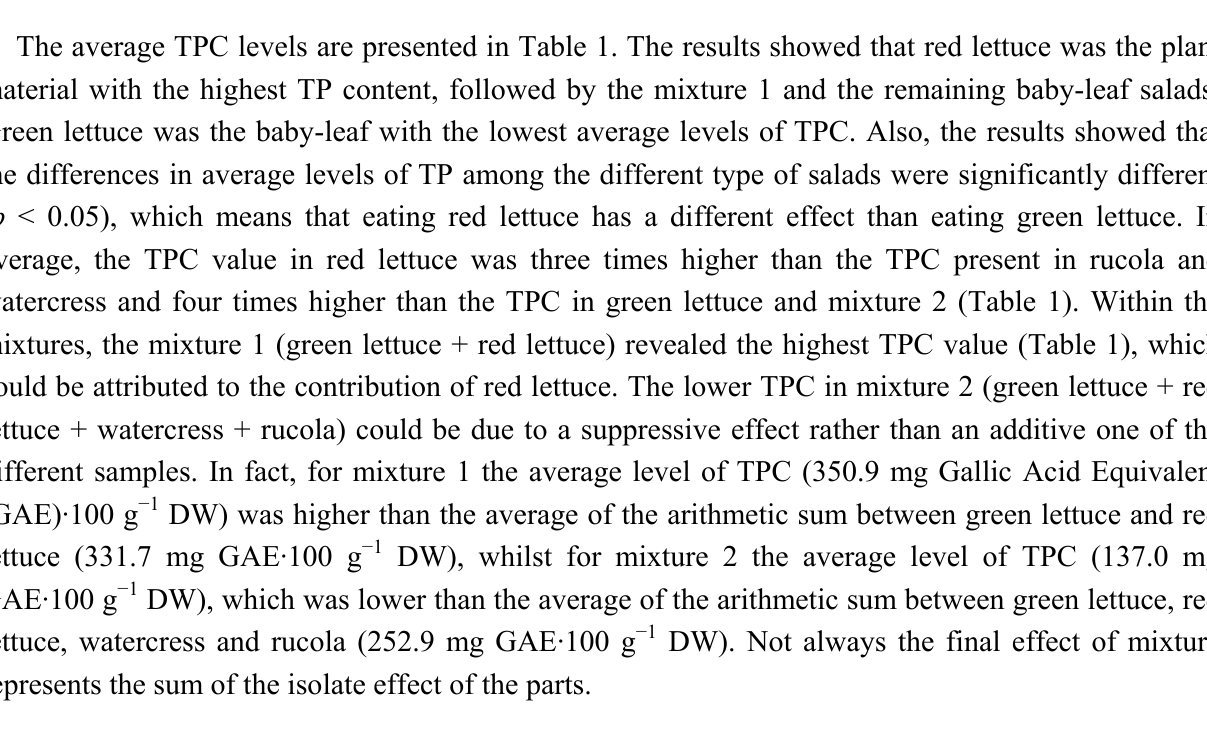
Table 1. Total phenolic compounds of the baby-leaf salads samples 1,2